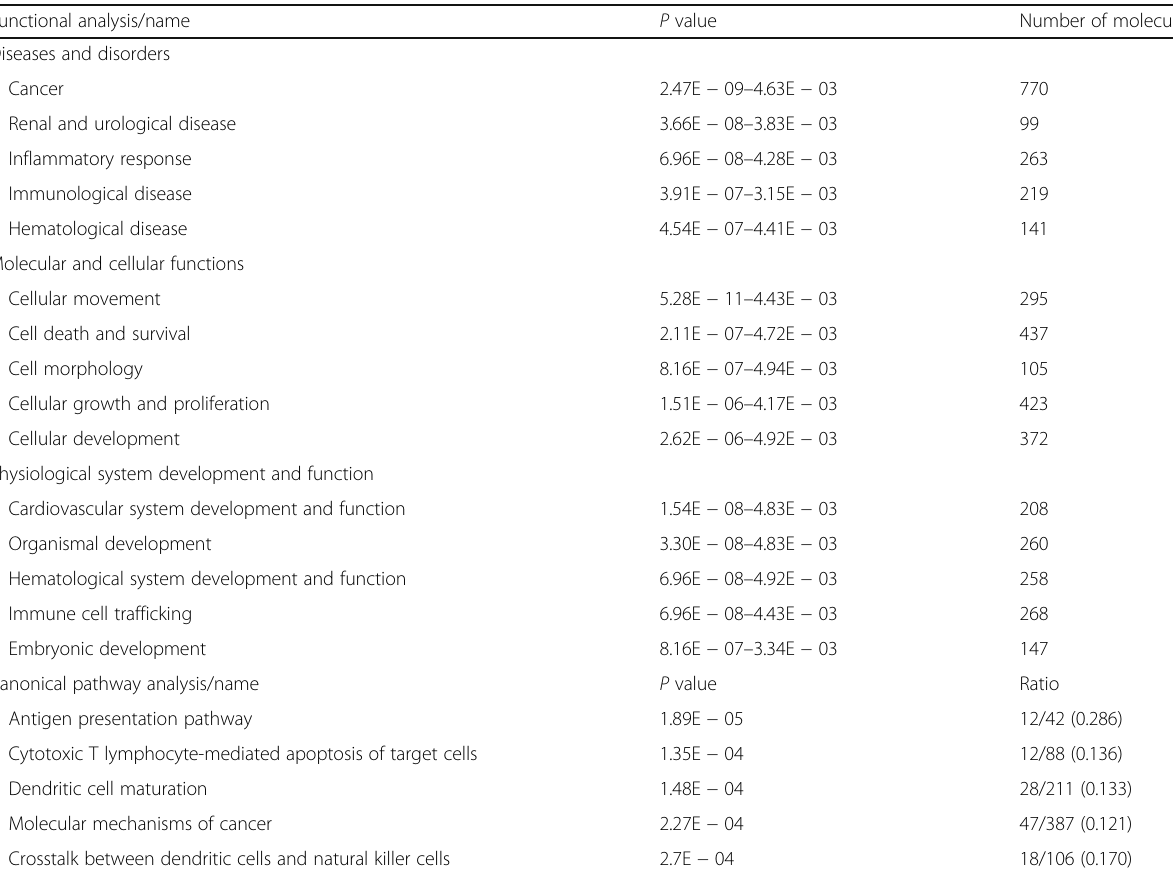
Table 4 Top 5 functional and canonical pathways from the Ingenuity Pathway Analysis Functional